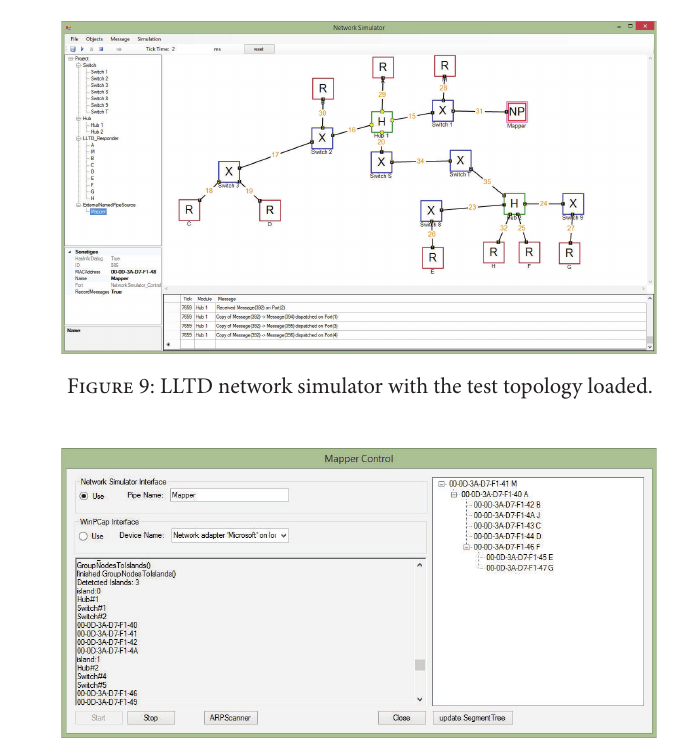
Figure 10: LLTD mapper application with the test topology’s segment